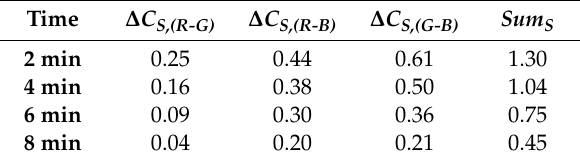
Table 2. Calculation and comparison of clustering data at different fixation times.